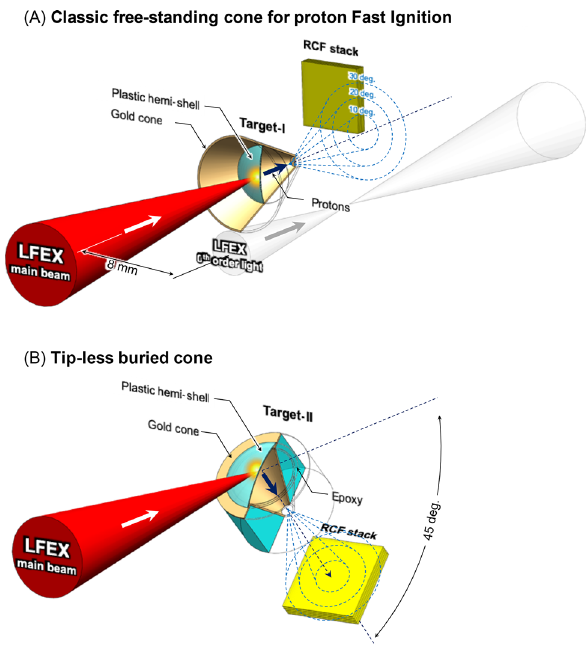
Figure 1. Schematic of the experimental setup. ( A ) Schematic of the classic free-standing cone as first proposed for proton fast-ignition. The LFEX laser is focused at normal incidence due to the cone geometry. The RCF- stack is positioned to the top-left quadrant in order to avoid the LFEX 0th order light (direct reflections from the compressor gratings). ( B ) Schematic of the tip-less buried cone target. The cone geometry allows for 45° laser incidence angle. In this way it is possible to avoid the risk of 0th order light irradiating the RCF stack and to collect the majority of the proton